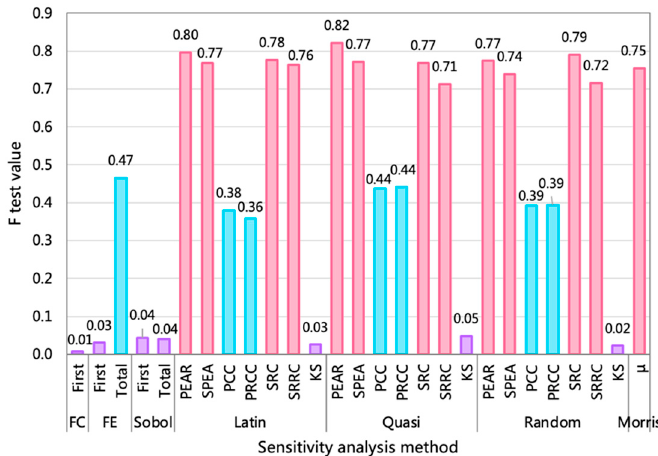
Figure 13. F-test values in different sampling and SA methods.